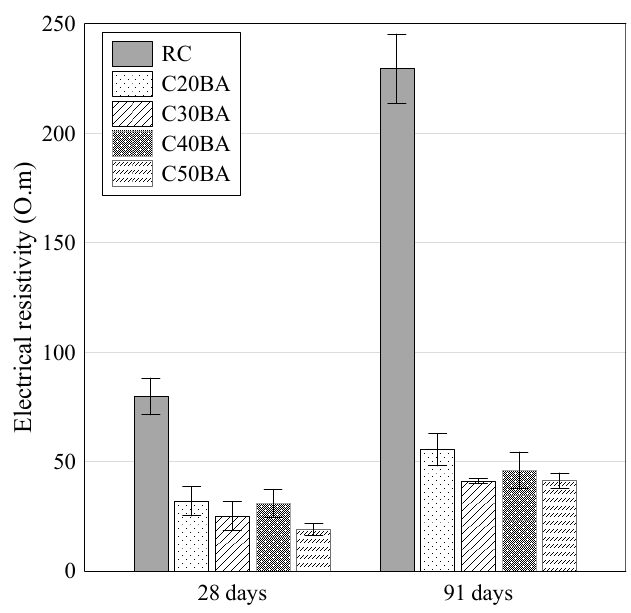
Ω .m) at 28 and 91